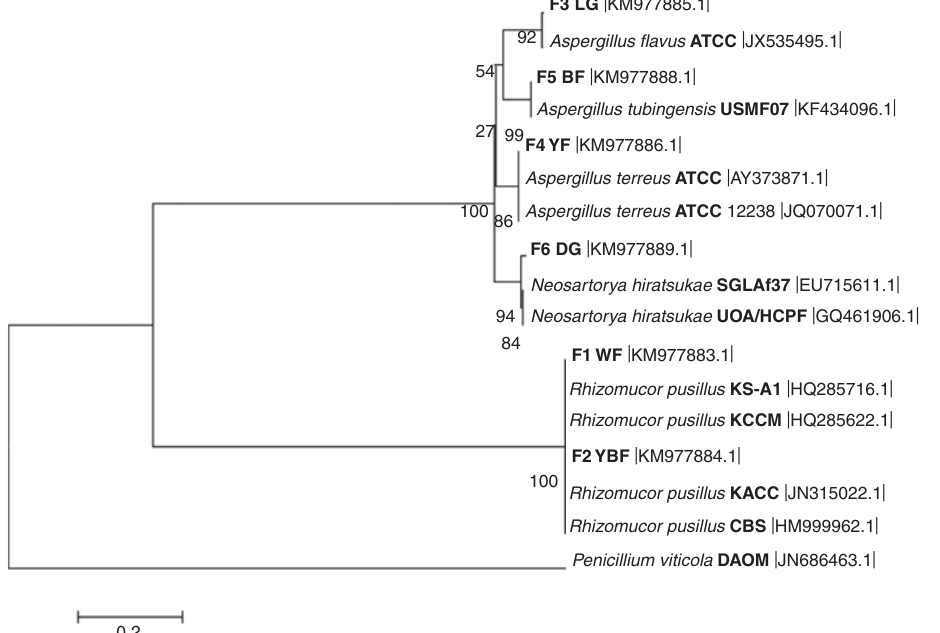
Figure 1: Phylogenetic tree of the fungal isolates with closest relatives based on a maximum parsimony analysis of ITS sequences. Length of ITS sequences for F1 = 578, F2 = 576, F3 = 548, F4 = 550, F5 = 543, and F6 = 548. Penicillium viticola DAOM was used as an out-group. Phylogenetic tree was constructed by using Mega 4.0 software.